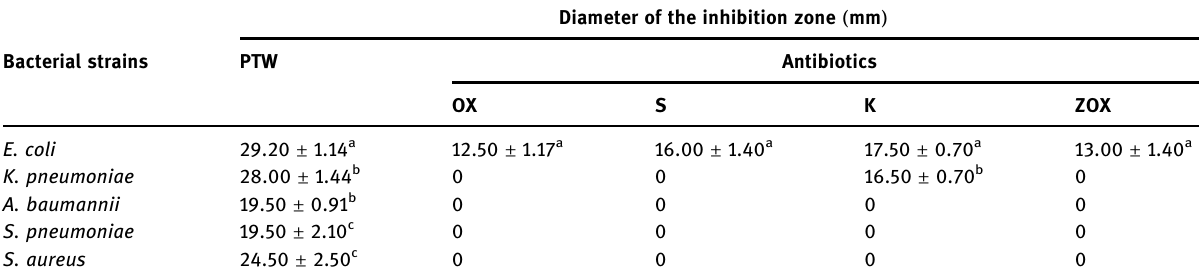
Diameter of the inhibition zone ( mm )